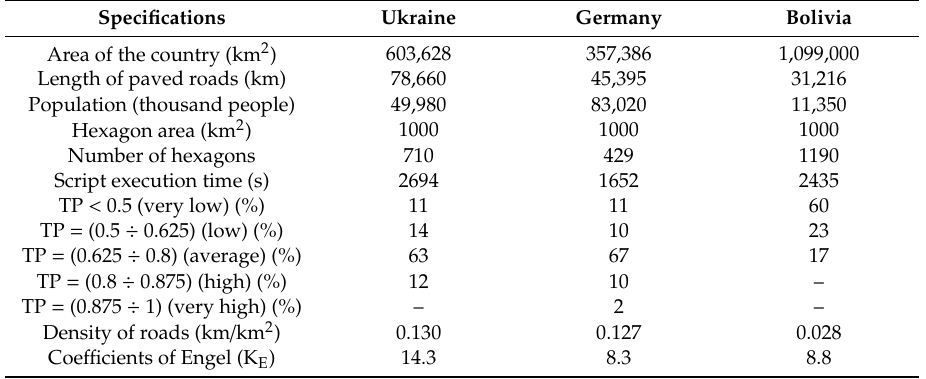
Table 2. Comparative characteristics of the calculation of transport development of a territory.